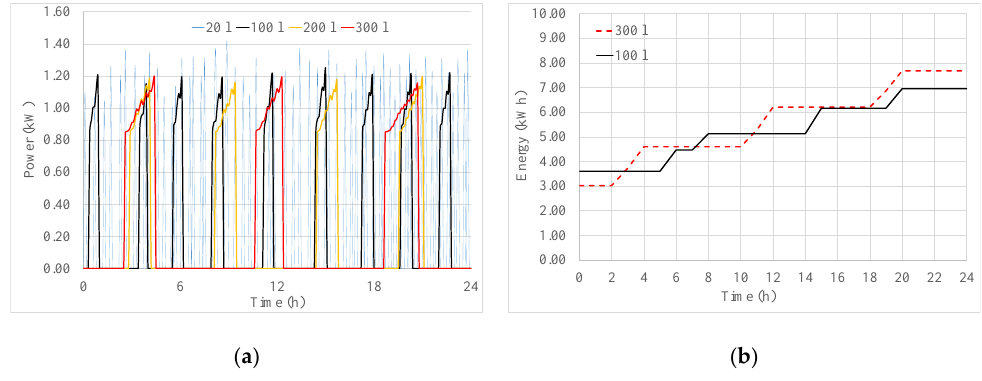
Figure 6. ( a ) Electric power profile and ( b ) cumulative energy curve of the HP for different tank sizes.